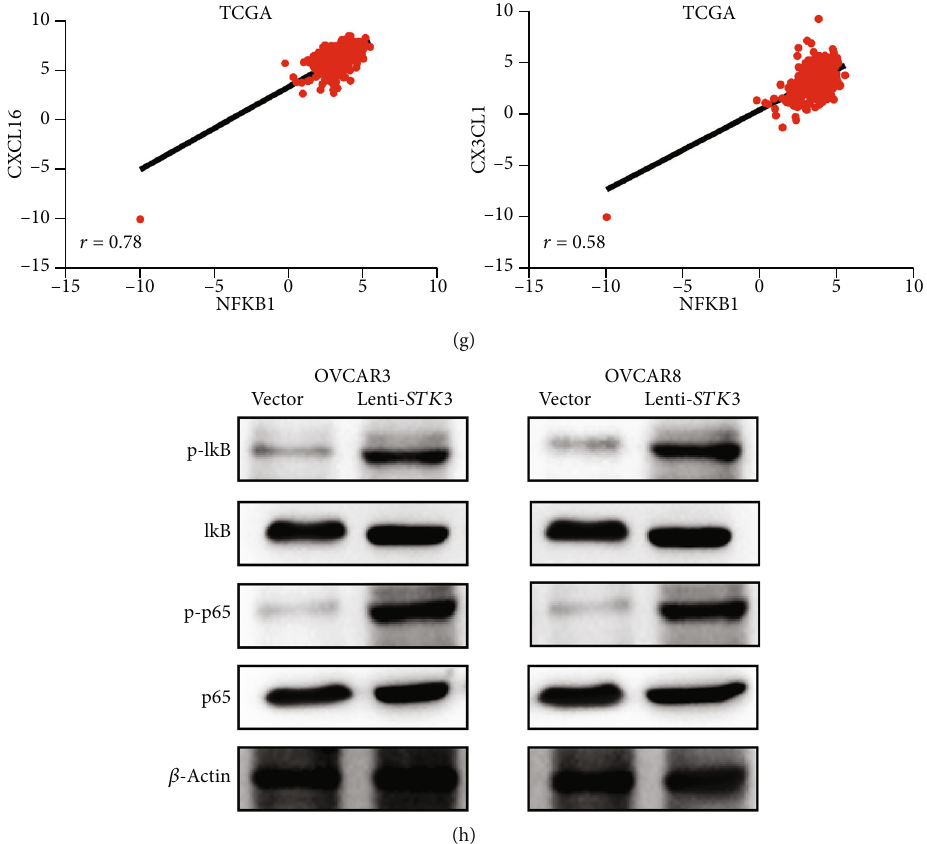
Figure 5: STK3 promoted release of CXCL16 and CX3CL1, migration of CD8+ T-cell, and activation of NF- κ B signaling. (a) Chemokine array of the conditional medium (CM) from vector and lenti-STK3 OVCAR8 cells. A. Table summarizing the relative signal intensity of indicated chemokines is presented in the lower left corner. (b) Real-time qPCR analysis of the e ff ect of STK3 overexpression on the CXCL16 and CX3CL1 mRNA level in OVCAR3 and OVCAR8 cells (two-tailed Student ’ s t -test, ∗ P < 0 : 05 ; ∗∗ P < 0 : 01 ). (c) ELISA analysis of the CXCL16 and CX3CL1 level in the CM from vector and lenti-STK3 OVCAR3 and OVCAR8 cells (two-tailed Student ’ s t -test, ∗∗ P < 0 : 01 ; ∗∗∗ P < 0 : 001 ). (d) E ff ects of rCXCL16 and rCX3CL1 on the migratory ability of human CD8+ T-cells. The number of cells was counted by Cellometer (two-tailed Student ’ s t -test, ∗∗ P < 0 : 01 ; ∗∗∗ P < 0 : 001 ; ∗∗∗∗ P < 0 : 0001 ). (e) Ovarian cancer cell culture supernatants were neutralized with anti-CXCL16 antibody and anti-CX3CL1 antibody and the migratory ability of CD8+ T-cells. The number of cells was counted by Cellometer (two-tailed Student ’ s t -test, ∗∗ P < 0 : 01 ; ∗∗∗ P < 0 : 001 ; ∗∗∗∗ P < 0 : 0001 ). (f) Correlation between STK3 and NFKB1 in the TCGA database. (g) Correlation between NFKB1 and CXCL16 or CX3CL1 in the TCGA database. (h) Western blot analysis of the e ff ect of the STK3 overexpression on the NF- κ B pathway